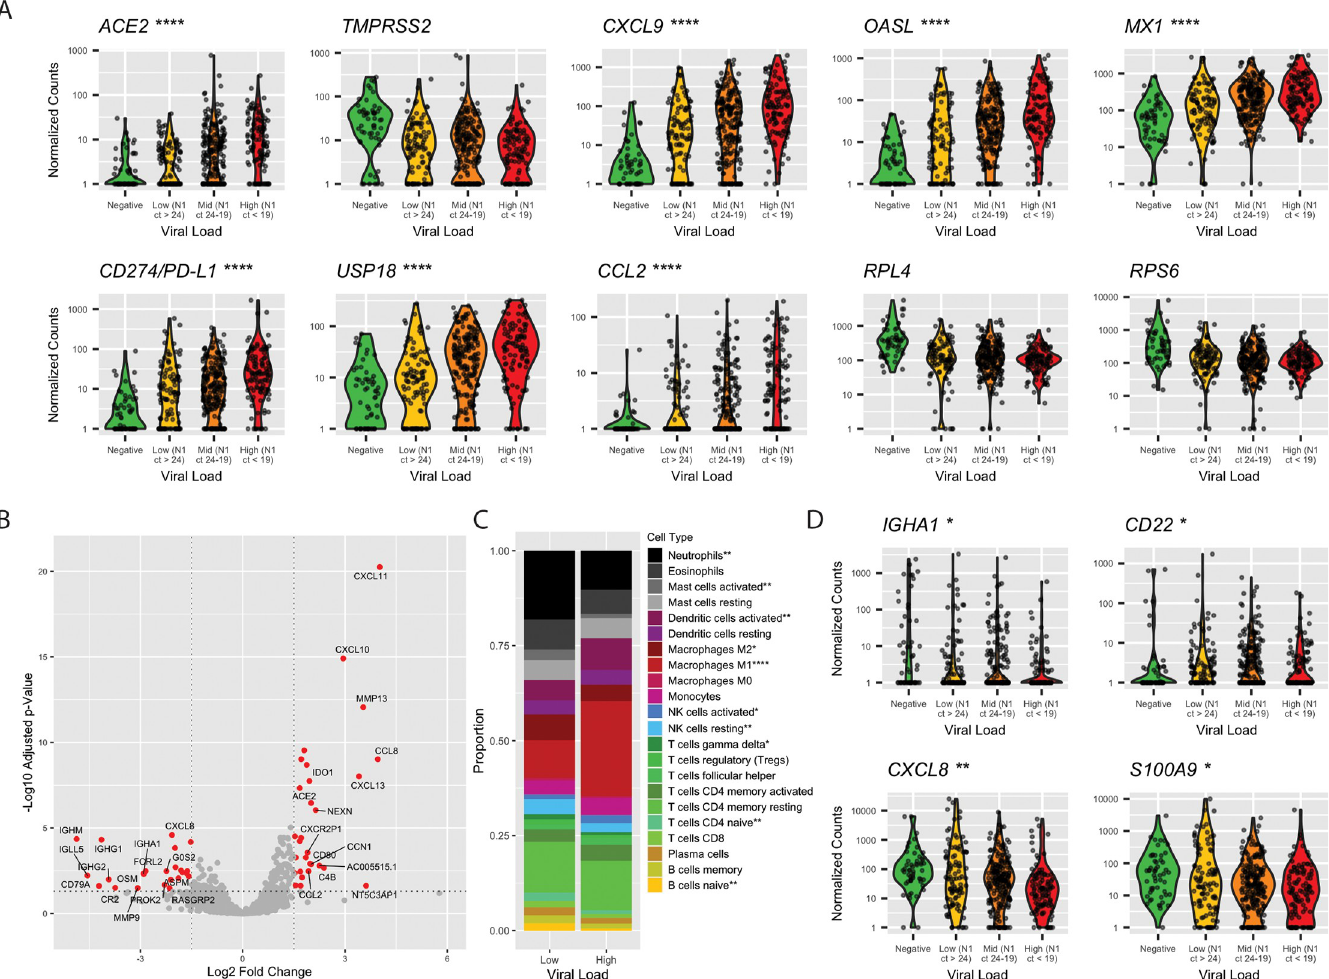
Fig 2. Differences in gene expression by SARS-CoV-2 viral load. (A) Violin plots of select genes by viral load. Statistical significance between low and high viral load calculated by Mann Whitney U test, � p < 0.05, �� p < 0.01, ��� p < 0.001, ���� p < 0.0001. (B) Volcano plot of 15 most up-regulated and 15 most down-regulated genes in SARS-CoV-2 high viral load samples relative to low viral load by log2 fold change. Red color indicates genes with log2 fold change > |1.5| and adjusted p < 0.05. (C) Proportion of cell types as a total of all immune cells, by CIBERSORTx. Significant differences in proportion of each cell type determined by t test, � p < 0.05, �� p < 0.01, ��� p < 0.001, ���� p < 0.0001. (D) Violin plots of B cell transcripts and neutrophil chemokine transcripts by viral load. Statistical significance between low and high viral load calculated by Mann Whitney U test, � p < 0.05, �� p < 0.01, ��� p < 0.001, ���� p < 0.0001. Raw data available in the GEO Repository, accession GSE152075. Ct, cycle threshold; GEO, Gene Expression Omnibus; N1, SARS-CoV-2 nucleocapsid gene region 1; NK, natural killer; SARS-CoV-2, severe acute respiratory syndrome coronavirus 2; Treg, regulatory T cell.